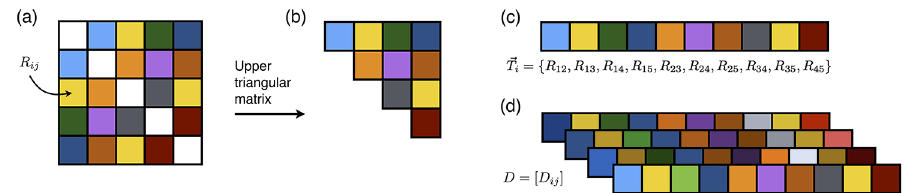
Fig 1. Schematic procedures of the functional network construction. ( A ) Functional network matrix, [ R ij ] , for a subject. ( B ) Upper triangular matrix of [ R ij ] . ( C ) Vectorization of the upper triangular matrix. ( D ) Stacking T i for all subjects to construct D , where the vector T i is the i -th row vector of D = [ D ij ]